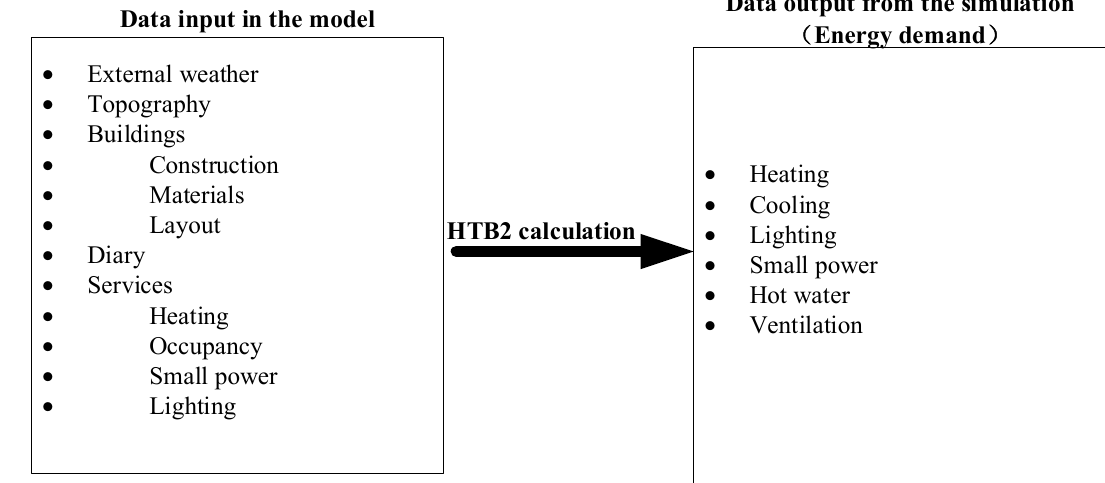
Figure 9. Data input to the data output of the model (HTB2 user manual 2.10). Table 5. The parametric setting for urban building energy simulation (the design standard for energy efficiency of residential buildings in hot summer and cold winter zone (2010); the design standard for energy efficiency of public buildings (2015)).